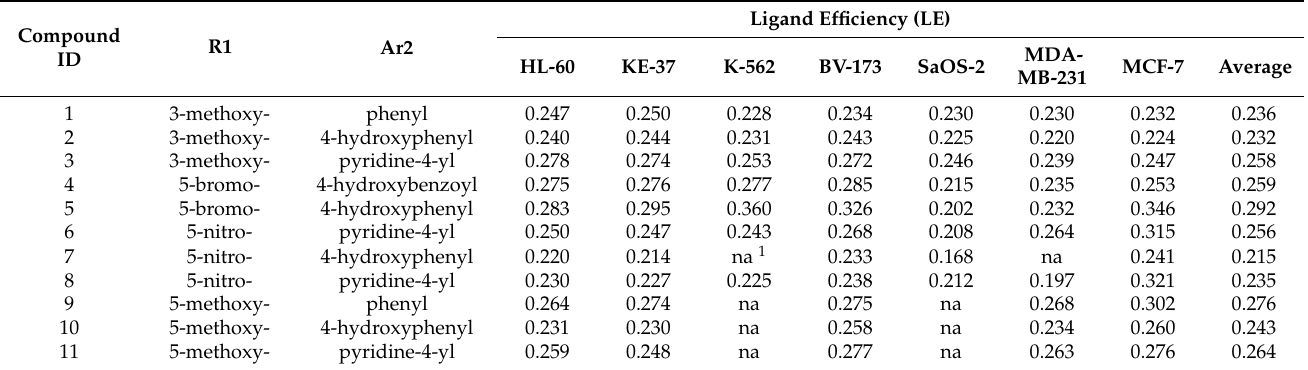
Table 2. Ligand efficiencies of the hydrazone derivatives from the training